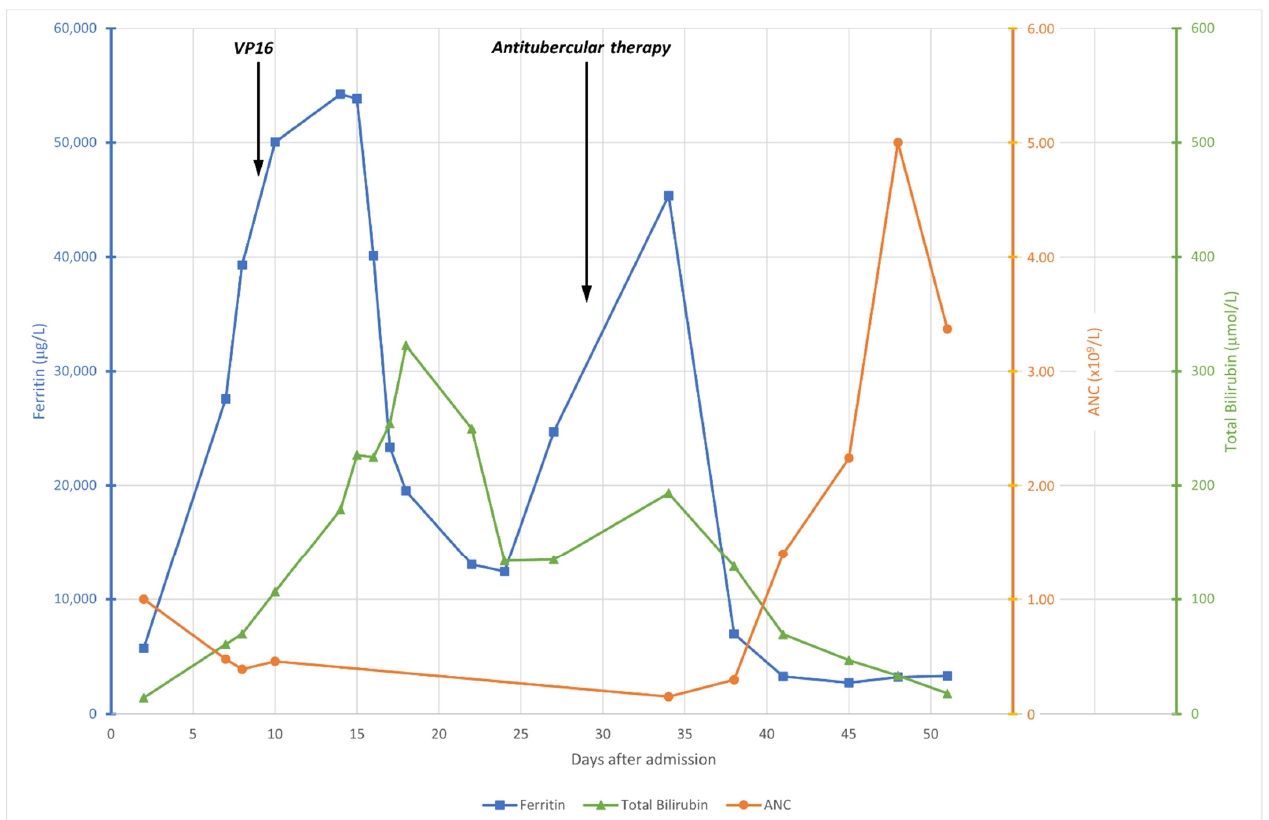
Figure 1. Ferritin (blue) total birilubin (green) and neutrophil count (orange) trend during the patient’s hospital stay (days after hospitalization). The black arrows indicate the two time points at which Etoposide (day 9) and antitubercolar treatments (day 29) were administered. ANC: Absolute Neutrophil Count; VP16: Etoposide.